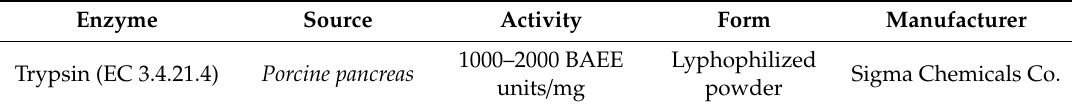
Table 2. Characteristics of